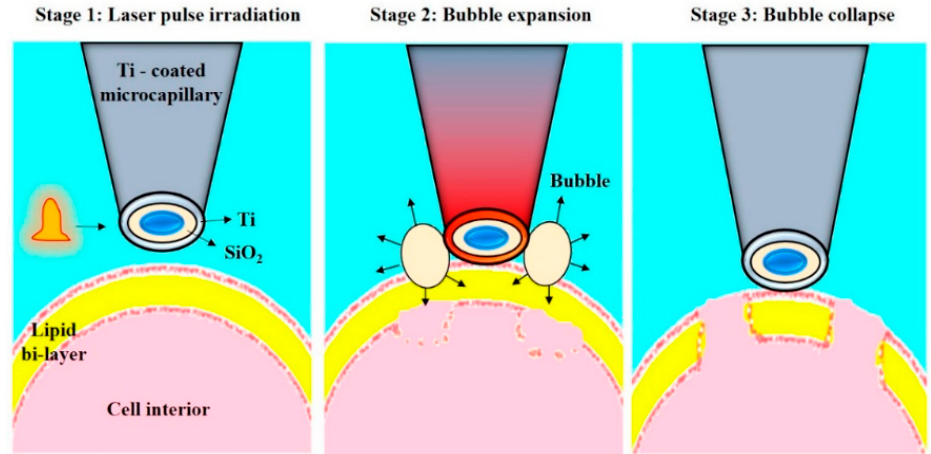
Figure 21. Schematic representation of the Nano blade. The figure depicts the process of cell membrane pore formation by creating microbubbles. Reprinted with permission from ref. [146]. Copyright © 2010 Optical Society of America.